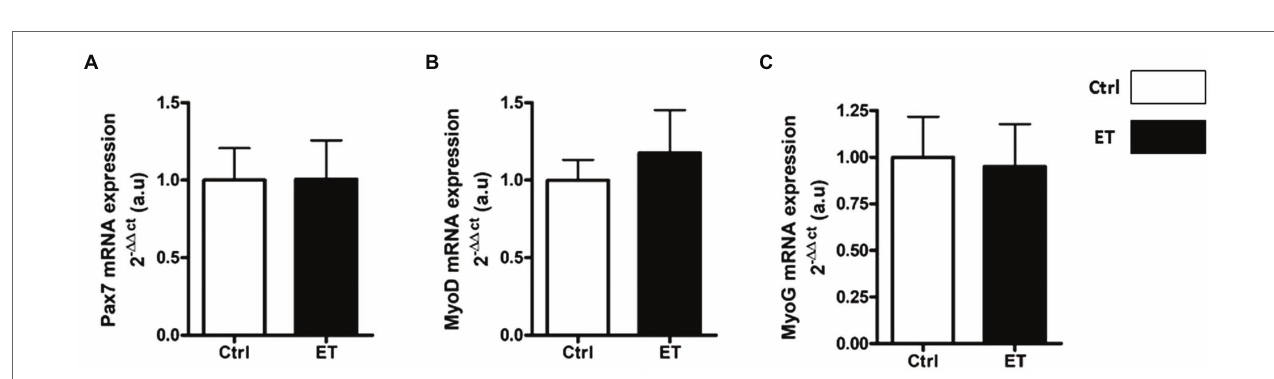
FIGURE 13 | Ergothioneine effect on transcription regulation of satellite cell markers. Satellite cell marker transcription regulation in gastrocnemius muscle. (A) Pax7 mRNA level. (B) MyoD mRNA level. (C) Myogenin mRNA level. * p < 0.05 vs.